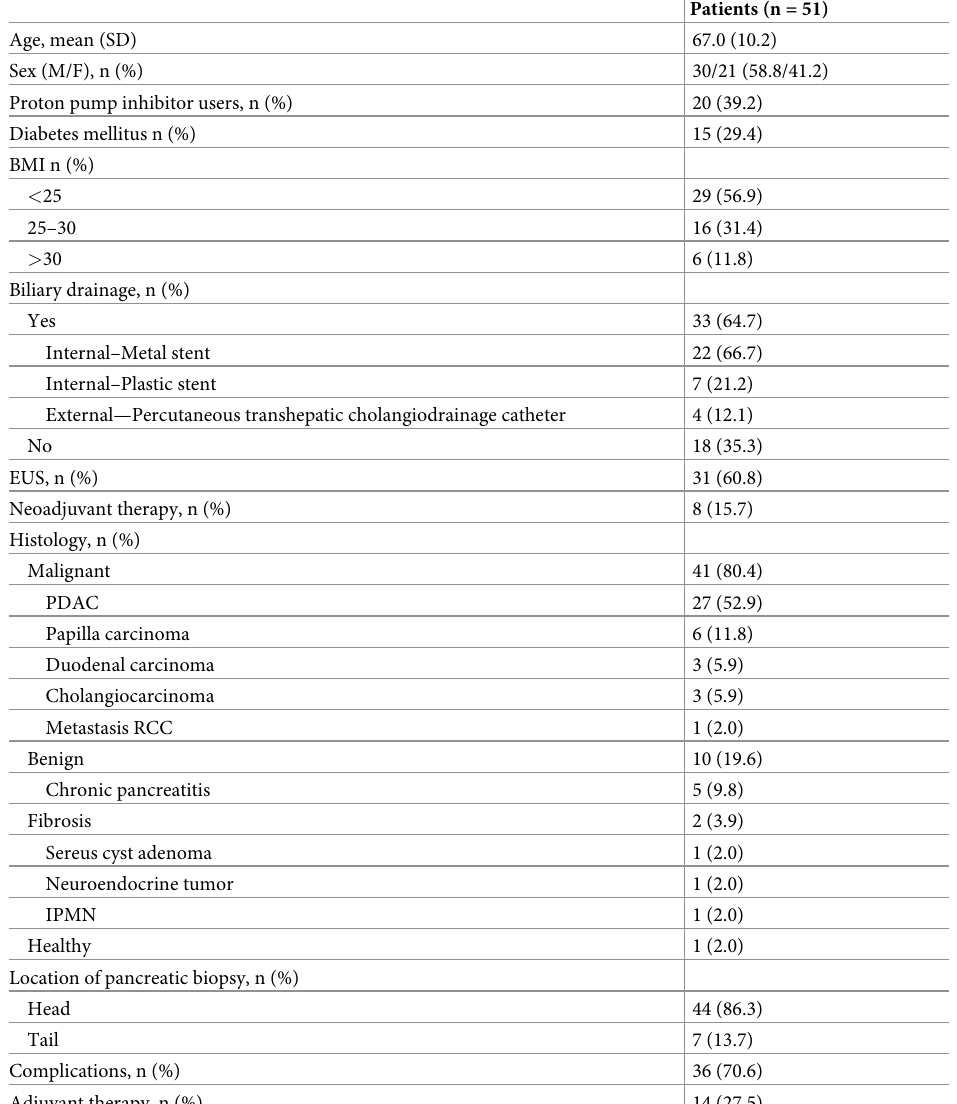
Table 1. Patient characteristics.